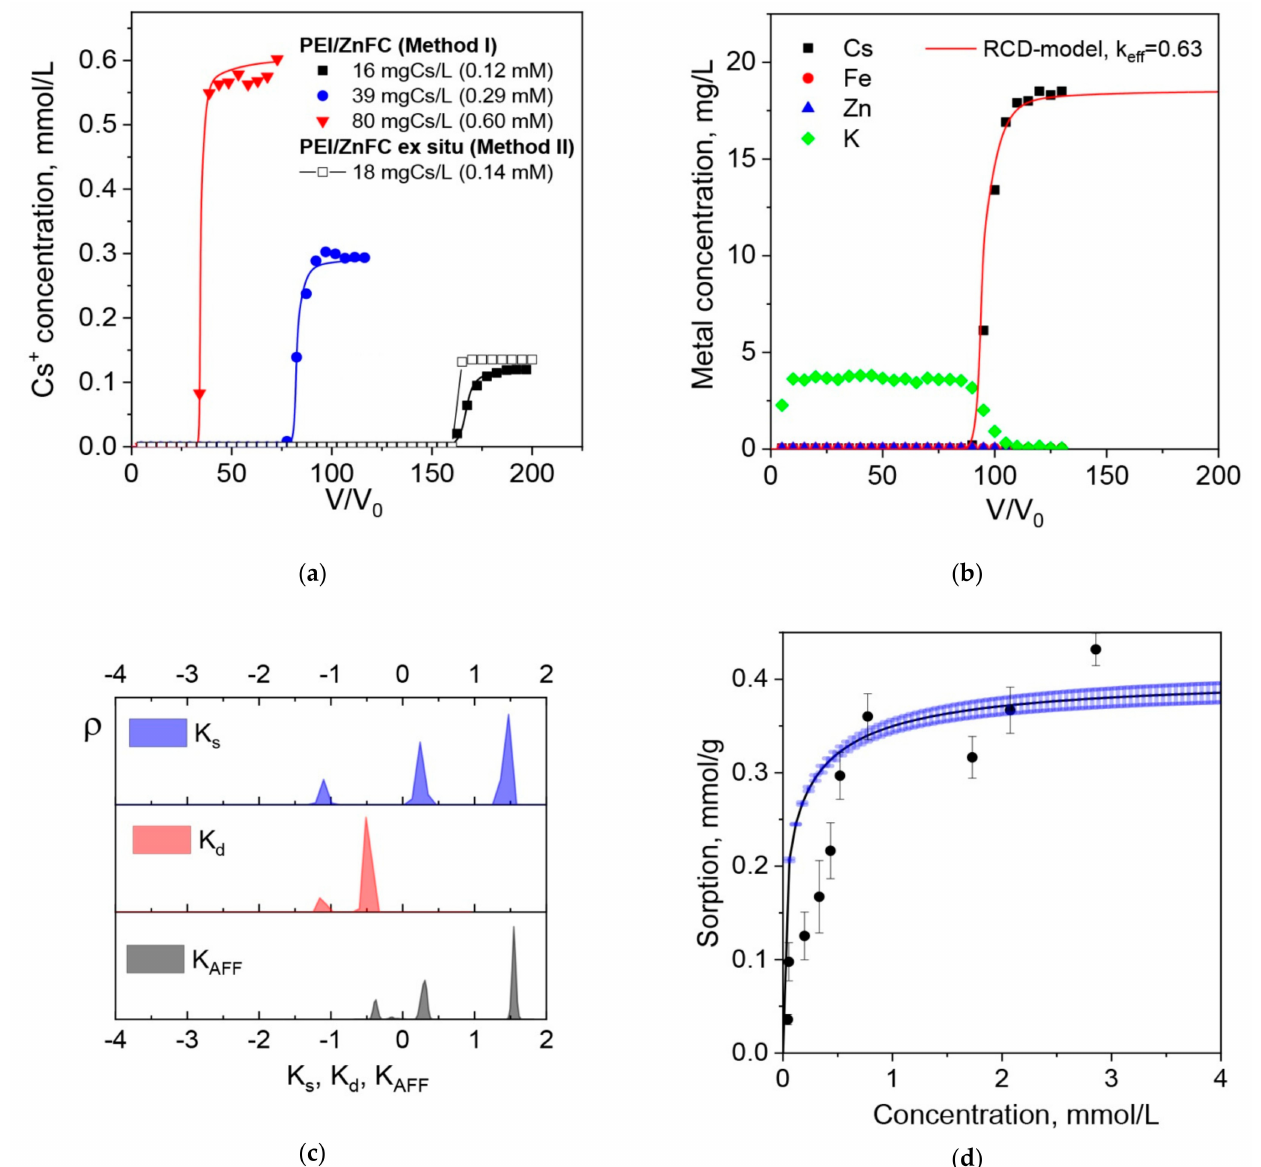
Figure 5. Breakthrough curves of Cs + ions sorption on PEI/ZnFC composites fabricated via the Methods I and II, pH = 5, flow rate 100 BV/h, monolith column diameter was 0.48 cm, bed length was 6 cm: dots—experimental data; lines—RCD model ( a ). Breakthrough curve of Cs + ions sorption on PEI/ZnFC composites (Method I) from the solution containing 19 mgCs/L at flow rate 145 BV/h and release profiles for zinc, potassium, and iron; column geometry is as in Figure 5a ( b ). 2D distributions of the Cs + sorption sites of PEI/ZnFC cryogel (Method I) over the constants of sorption (K s ) and desorption (K d ) rates and affinity constants (K AFF ) calculated using the rate-constant distribution (RCD) model ( c ). Isotherm of Cs + ions sorption on PEI/ZnFC cryogel (Method I): dots—experimental data; line—calculations using RCD function ( d